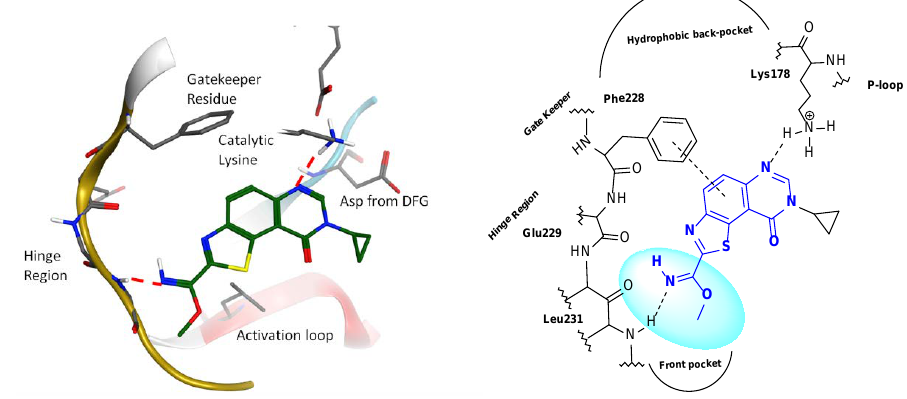
Figure 1. Results of molecular modeling studies (docking experiments) ( left ) and schematic representation ( right ) of the predicted binding modes of thiazolo[5,4- f ]quinazolin-9(8 H )-ones (Scheme 2, in DYRK1A).